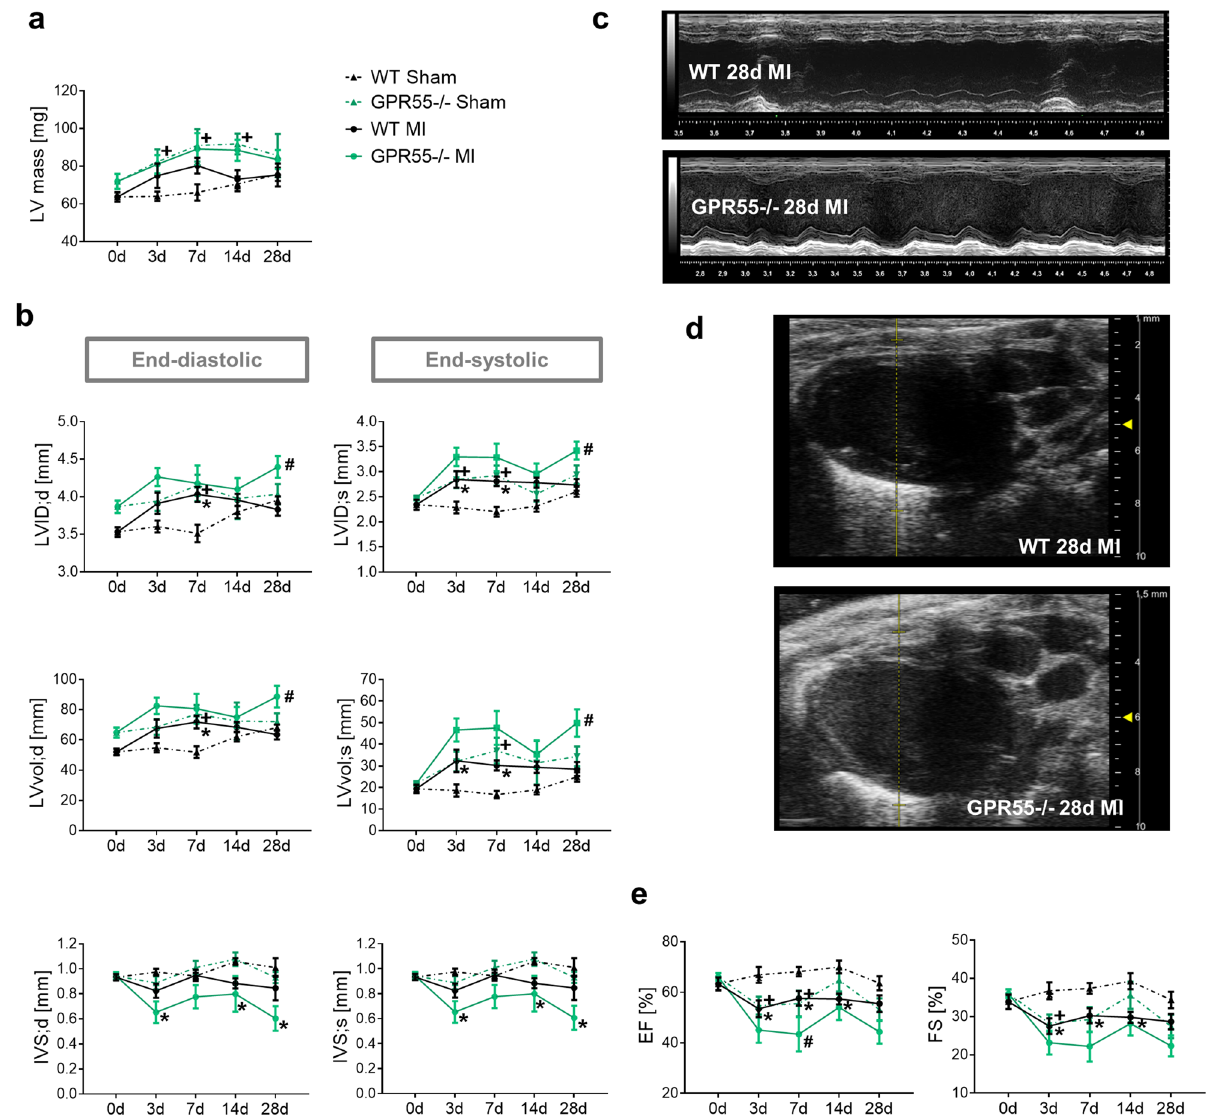
Figure 7. Impact of GPR55 deficiency on structural and functional maladaptive remodelling following MI. ( a ) LV mass, ( b ) diameter, volume and IVS thickness acquired by echocardiographic analyses of WT and GPR55−/− mice under basal conditions (0 day) and 3, 7, 14 and 28 days post-MI/sham surgery. ( c ) Representative long-axis M-mode and ( d ) B-mode projections at 28 day post-MI in WT and GPR55−/− mice. ( e ) LV function of WT and GPR55−/− mice under basal conditions (0 day) and 3, 7, 14 and 28 days post-MI/sham surgery. 0 day values of WT and GPR55−/− mice before MI induction are the same data as displayed in Fig. 1a and Table S1 as baseline data. Circles and triangles indicate mean ± SE (n = 7–14/group). *p < 0.05 vs. corresponding Sham, # p < 0.05 vs. corresponding WT; + p < 0.05 GPR55−/− Sham vs. WT Sham (Two-way ANOVA with Sidak’s post hoc